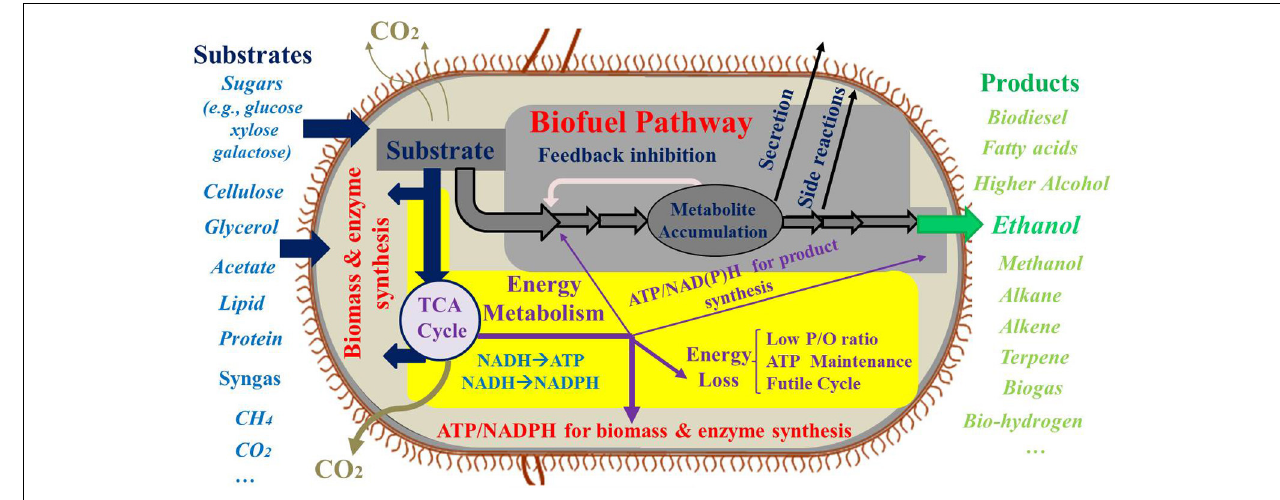
FIGURE 1 | Carbon and energy limitation for